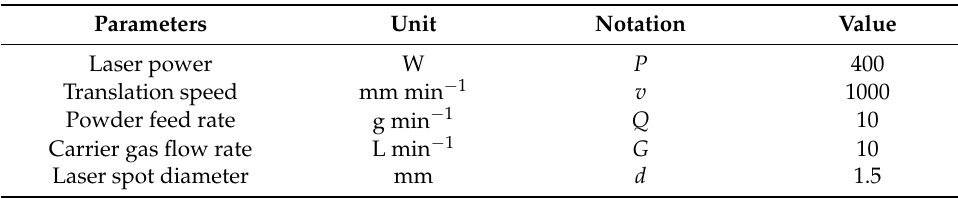
Figure 2. Schematic representation of three different deposition strategies. Table 4. Constant process